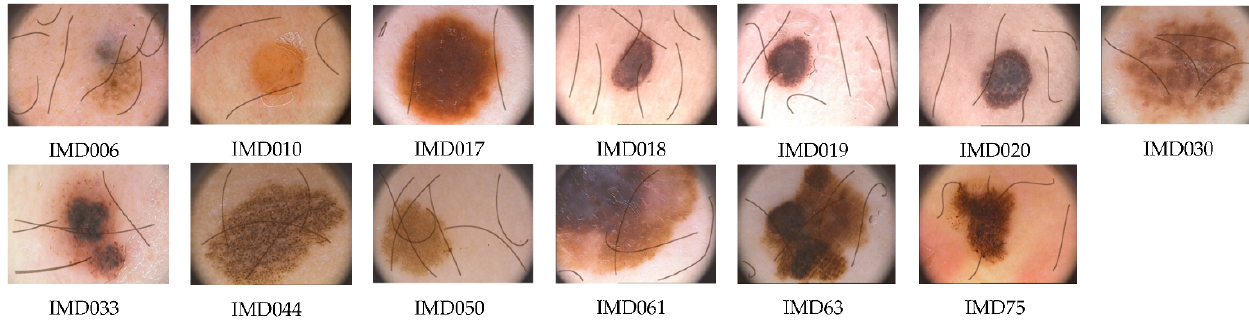
Figure 7. Image dataset sNH-data selected randomly from NH-data .